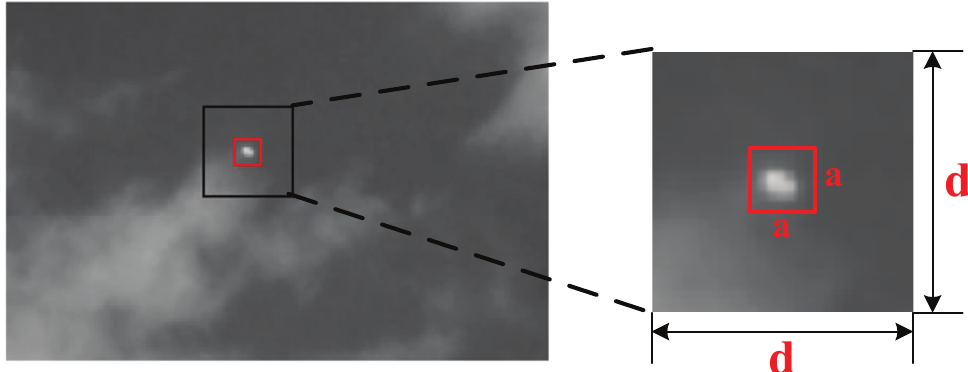
Figure 4. The background region and target region of the infrared small